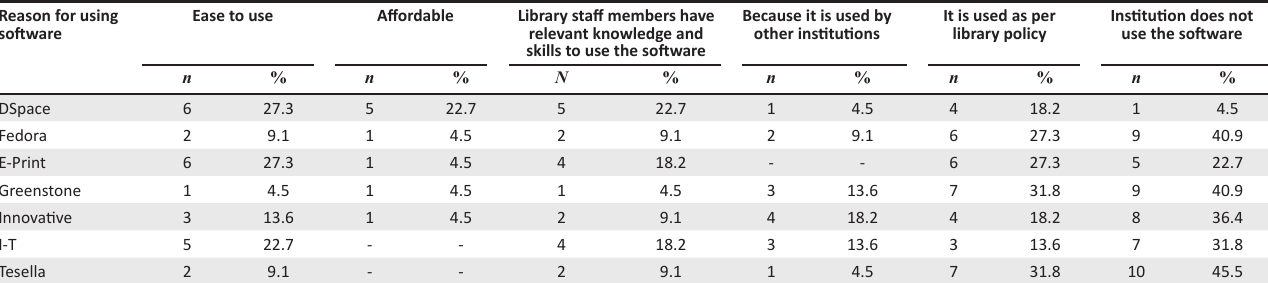
TABLE 3: Motivation to use software. Reason for using